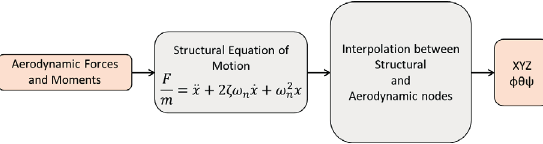
Fig. 8. Structural dynamics block of the CA 2 LM framework